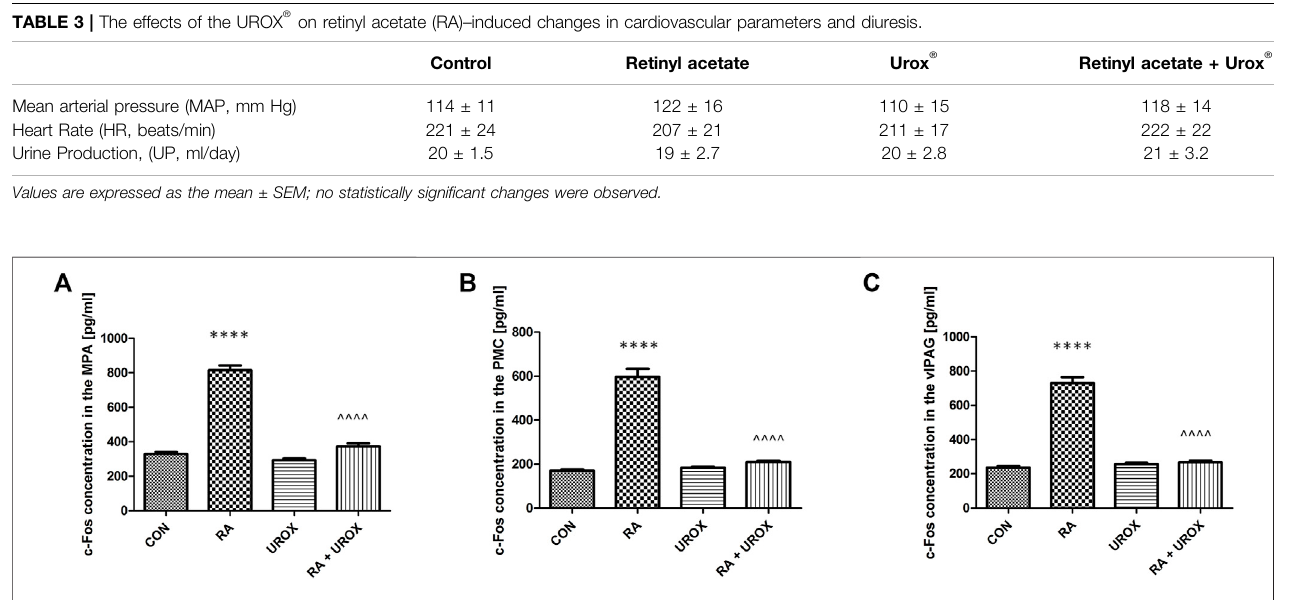
Values are expressed as mean ± SEM; no statistically signi fi cant changes were observed.